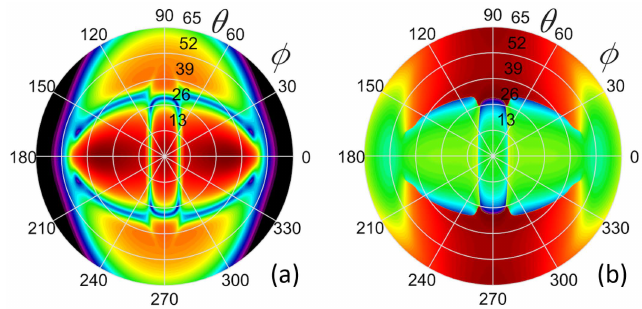
Figure 2. P-UPS for [0 ˝ ] 8 C/E laminate: amplitude ( a ) and time-of-flight (TOF) ( b ) landscape